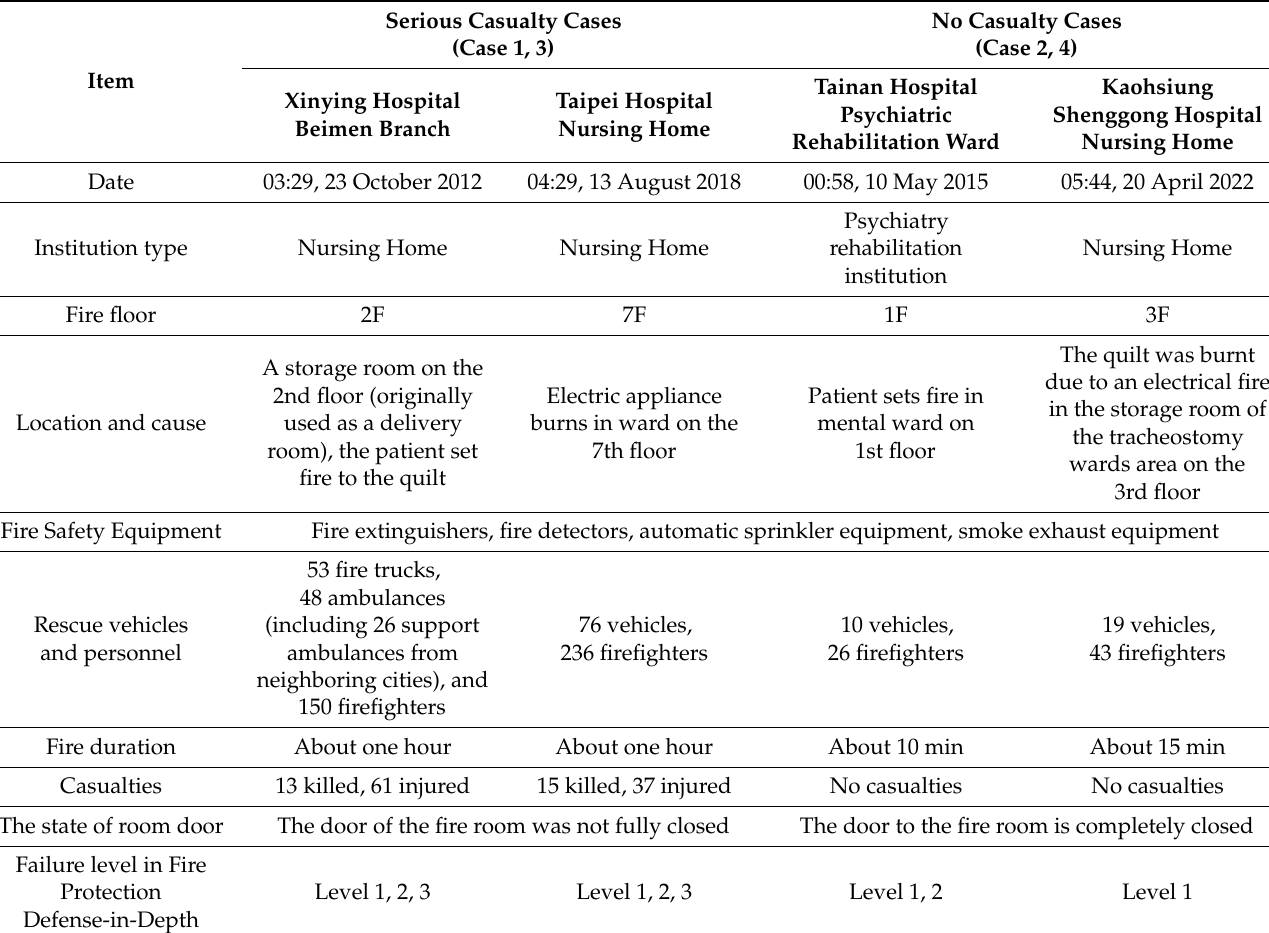
Table 3. Comparison and explanation of four nighttime fire